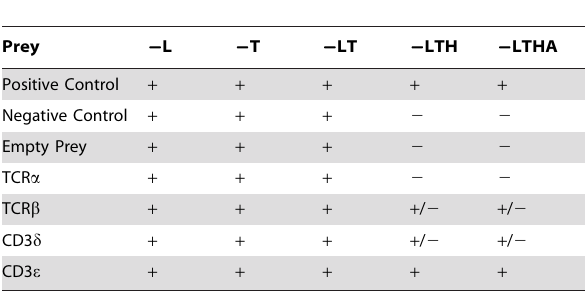
Table 2. CD3 d interacts with TCR subunits in S. cerevisiae .